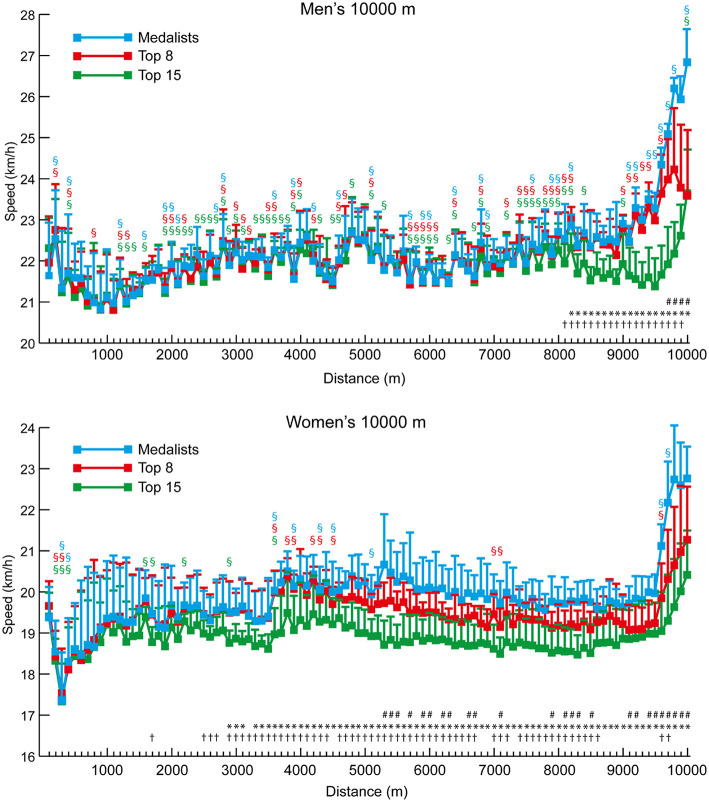
The mean (+ SD) 100-m segment speed for each group of men and women 10,000 m athletes. Differences between successive segments (p < 0.05, d ≥ 0.61) are represented by § (blue for medalists, red for Top 8, and green for Top 15). Differences in segment speed between groups (p < 0.05, d ≥ 0.61) have been annotated for medalists vs. Top 8 (#), medalists vs. Top 15 (*), and Top 8 vs. Top 15 (†).